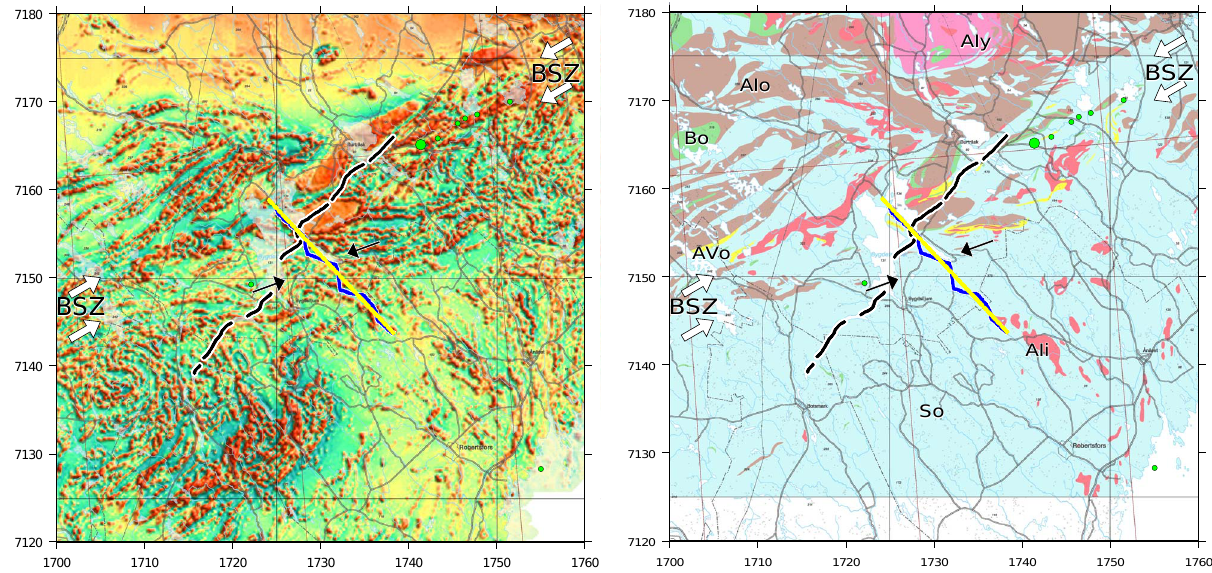
Fig. 2. Seismic profile (blue line) plotted on the residual magnetic field anomaly map (left) and the overview geological map (right). Yellow line is the CDP processing line. Black curve shows the surface trace of the Burtr¨ask fault. Magnetic and geological maps are courtesy of the Geological Survey of Sweden (SGU). Large green circle shows the Lappvattnet nickel mine (now closed) and the smaller green circles are mineral deposits of nickel based on data from Kathol and Weihed (2005). White arrows show the approximate location of the Burtr¨ask Shear Zone (BSZ). Black arrows indicate a topographic low. AIy – Acidic intrusive rocks (1.87–1.66Ga) , AIi – Acidic intrusive